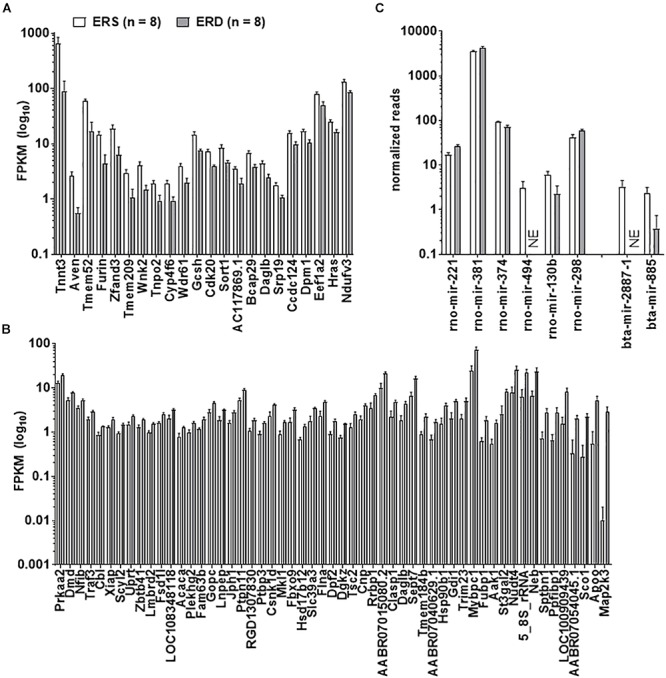
Transcriptome and miRNA differences between treatments. Data in the figure demonstrate transcriptome-wide and miRNA differences between treatments. Only 22 mRNAs were greater in ERS versus ERD rats (thresholds for significance listed in Section “Materials and Methods”) (A), whereas 55 mRNAs were greater in ERD versus ERS rats (B). (C) Demonstrates that six rat miRNAs were different between treatments, whereas two bovine miRNAs were different. ERS, EVs and RNA-sufficient; ERD, EVs and RNA-depleted; NE, not expressed at a detectable level.